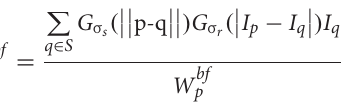
Occlusion detection based on the LRC is used to detect the disparity of all pixels in an image. When the disparity in the left and right imaging planes is inconformity, the pixels are regarded as the occluded points. To figure out occluded points, the disparity error is defined